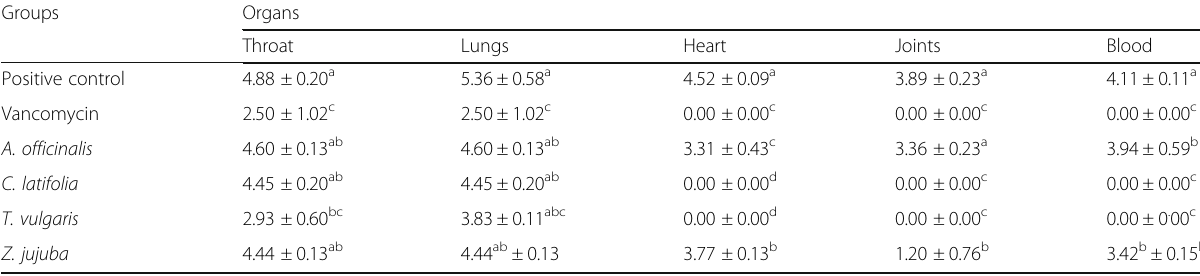
Table 5 Effect of treatment with selected medicinal plants on bacterial load of different tissues Groups